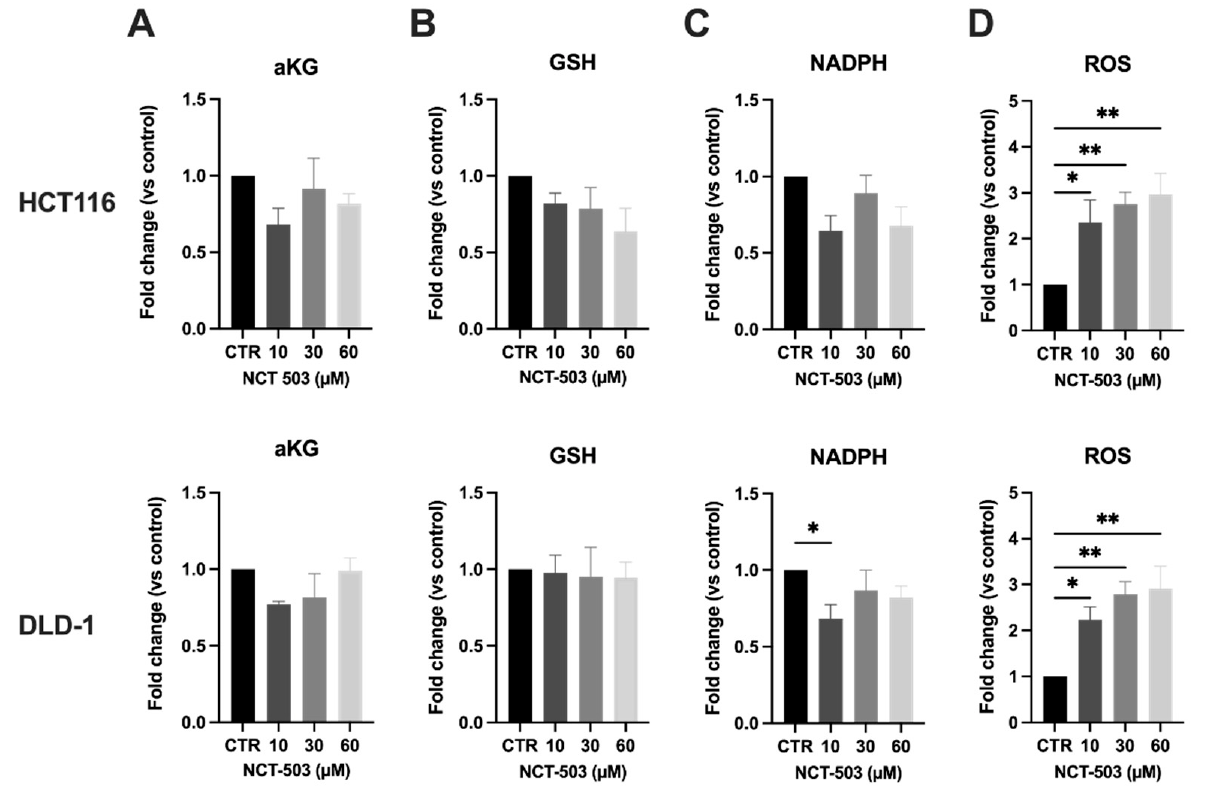
Figure 5. PHGDH inhibition mainly disrupts ROS homeostasis in human hypoxic colorectal cancer cells. HCT116 (top) and DLD-1 (bottom) cells were treated with NCT-503 for 5 h at indicated concentrations under hypoxic conditions (0.1% O 2 ). ( A ) aKG levels—normalized to control; ( B ) GSH levels—normalized to control; ( C ) NADPH levels—normalized to control; ( D ) ROS levels—normalized to control. Data are shown from at least four replicates as mean ± SEM. One-way ANOVA with Dunnett’s multiple comparison test was used to calculate statistics: * p < 0.05, ** p < 0.01.